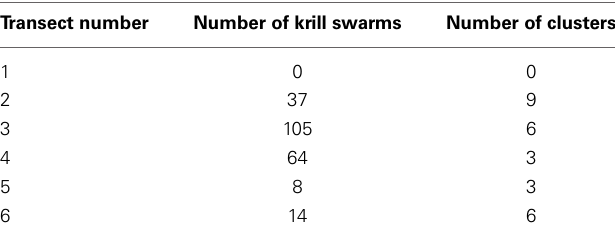
Table 3 | Number of unique krill aggregation clusters identified for each transect.